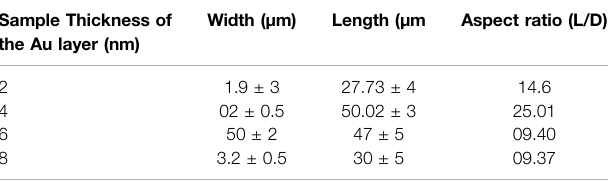
TABLE 2 | Average dimensions and aspect ratio of nanorods with respect to Au thickness. Sample Thickness of Width the Au layer (nm)